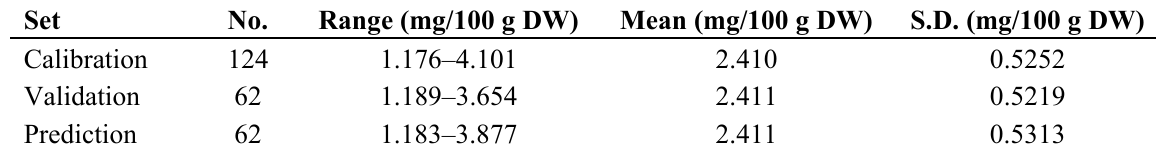
Table 1. Statistics of glutamic acid content of oilseed rape